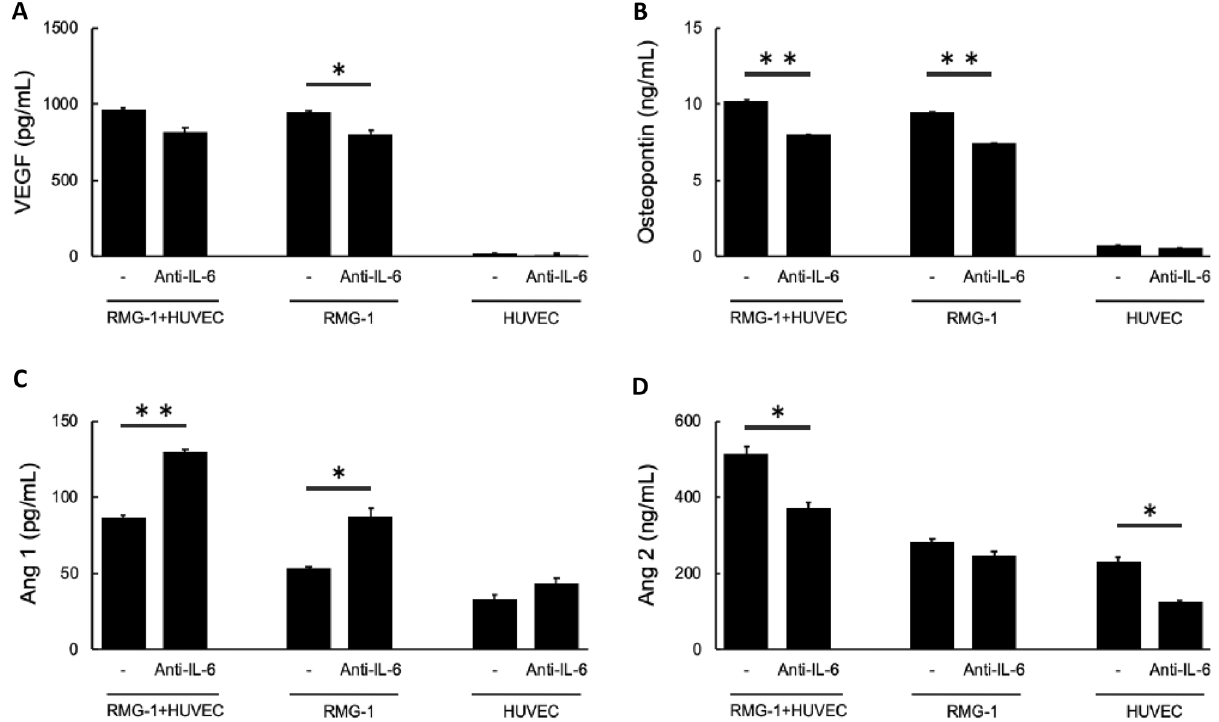
Figure 3. Angiogenic factors released by RMG-1 and HUVEC. ( A ) VEGF, ( B ) osteopontin, ( C ) Ang1, and ( D ) Ang2 production from RMG-1 and HUVEC in response to IL-6 signal blockade determined by ELISA assay. Data of HUVEC was calculated by the subtraction the data of RMG-1 mono-culture from that of RMG-1 + HUVEC. Error bars are SEs. *P < 0.05, **P <